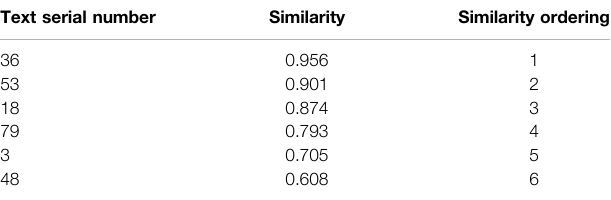
TABLE 2 | Top six historical texts in similarity